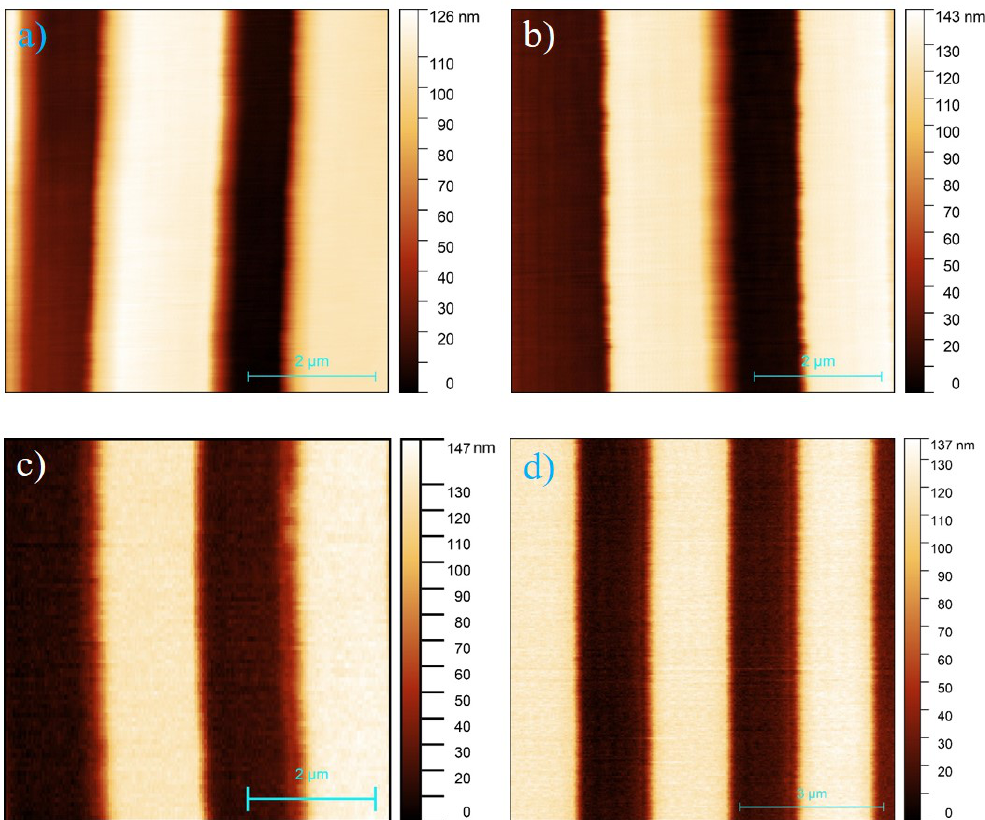
Figure 5. Imaging of TGZ-100 calibration sample with 6 by 6 micron size (a to c) for at 400 by 400 pixel resolution in tapping mode at 4 lines per second ( a ) uncoated regular active probe in air, ( b ) coated probe in air, ( c ) coated probe in crude oil environment, ( d ) coated probe in crude oil with 8 by 8 micron size and 600 by 600 pixel resolution image at lower speed 0.5 line per second for better edge